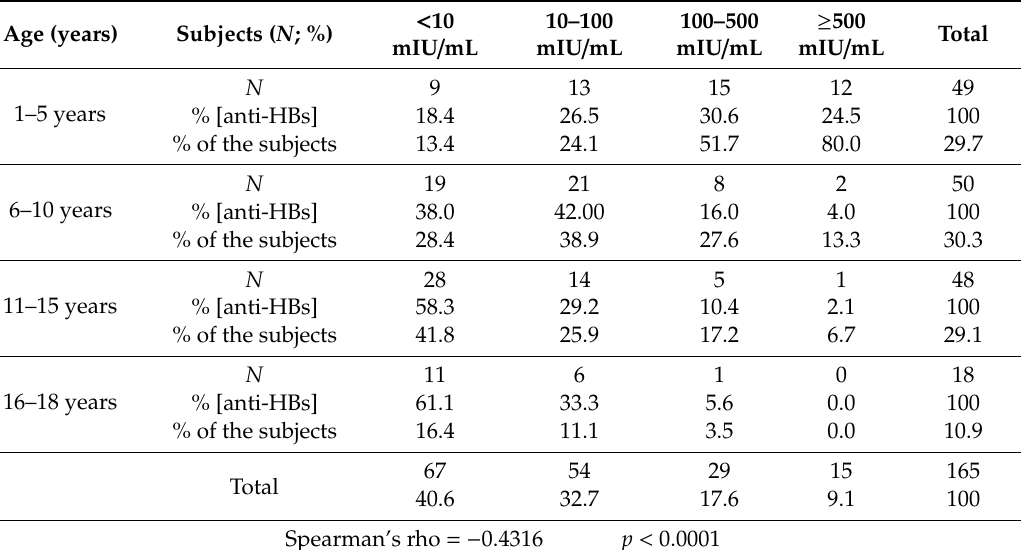
Table 2. Summary of anti-HBs serological results in the study